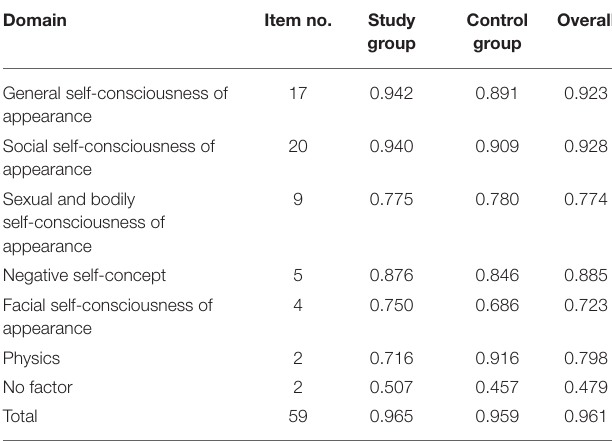
TABLE 1 | Reliability and internal consistency of Chinese DAS 59 using Cronbach’s alpha.